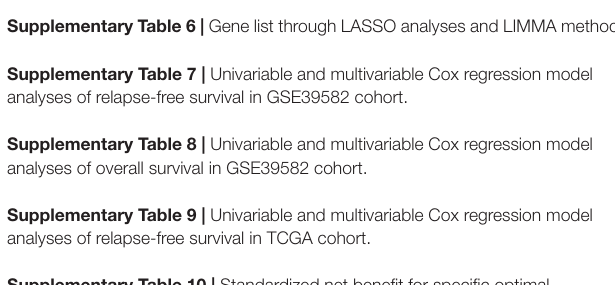
Supplementary Table 5 | Result scores of GSVA in GSE39582 and GSE14333. Supplementary Table 6 | Gene list through LASSO analyses and LIMMA